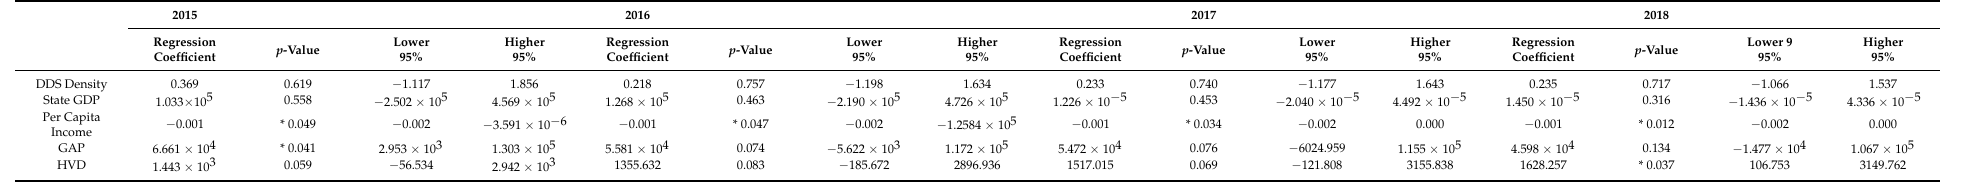
Table 3. Multiple linear regression analysis on DCPP controlling for DDS density, state GDP, per capita income, GAP and